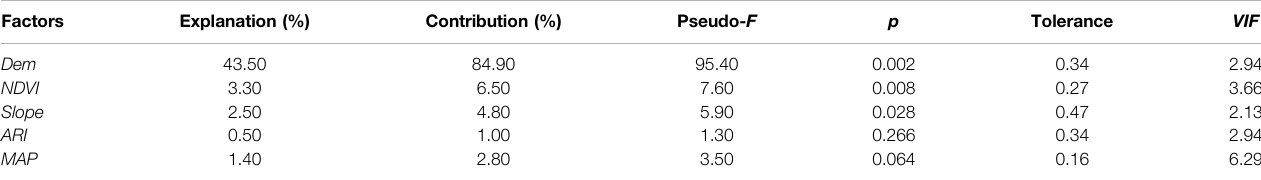
TABLE 4 | The proportions ofthe variation explained (explanation rate) and contribution of the in fl uencing factors to variations ofsoil organic carbon density ( SOCD ) and soil total nitrogen density ( STND ) to a depth of 100 cm in the redundancy analysis.